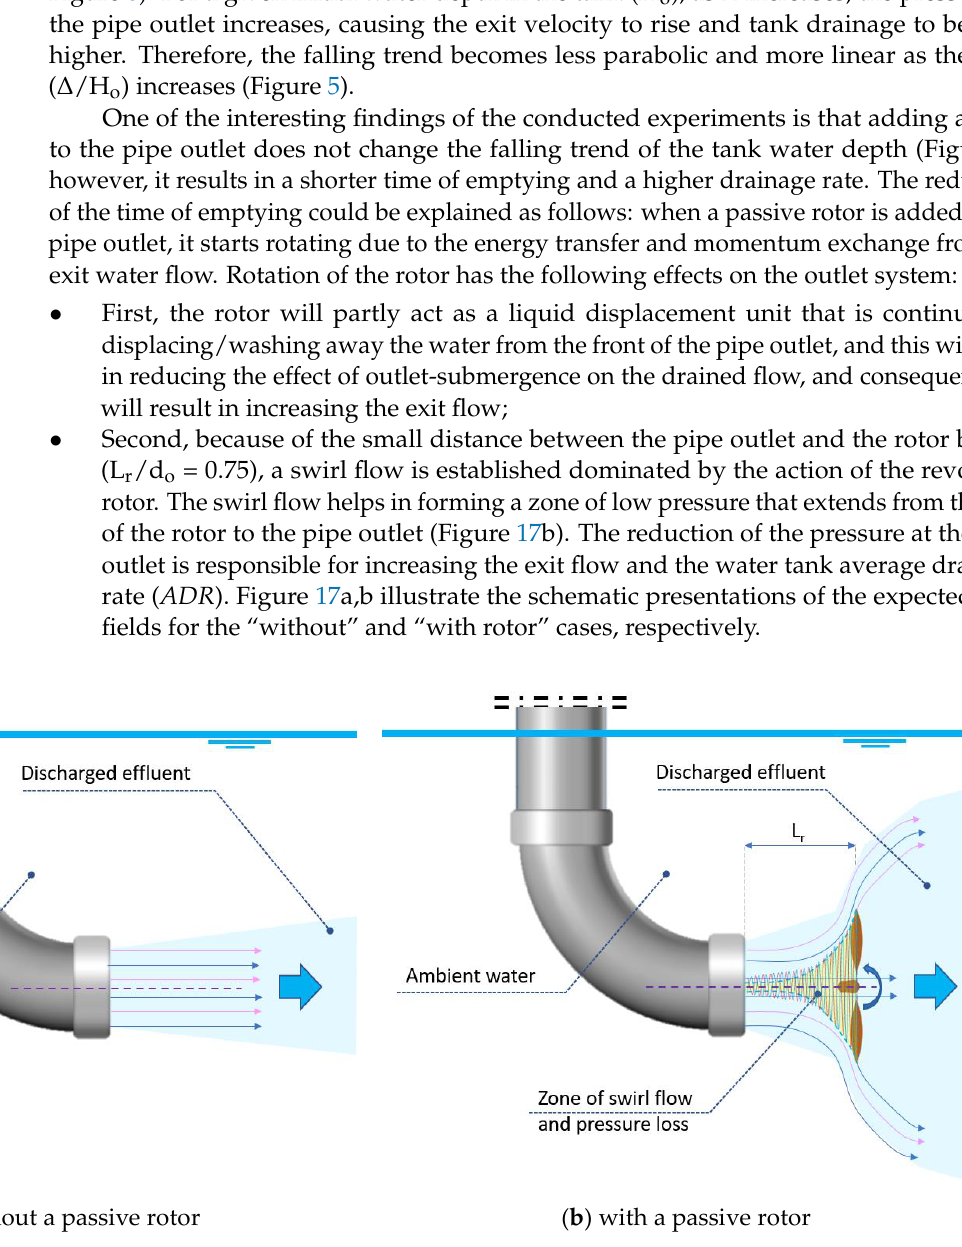
Figure 17. Schematic presentation of the flow field downstream of a submerged pipe outlet.